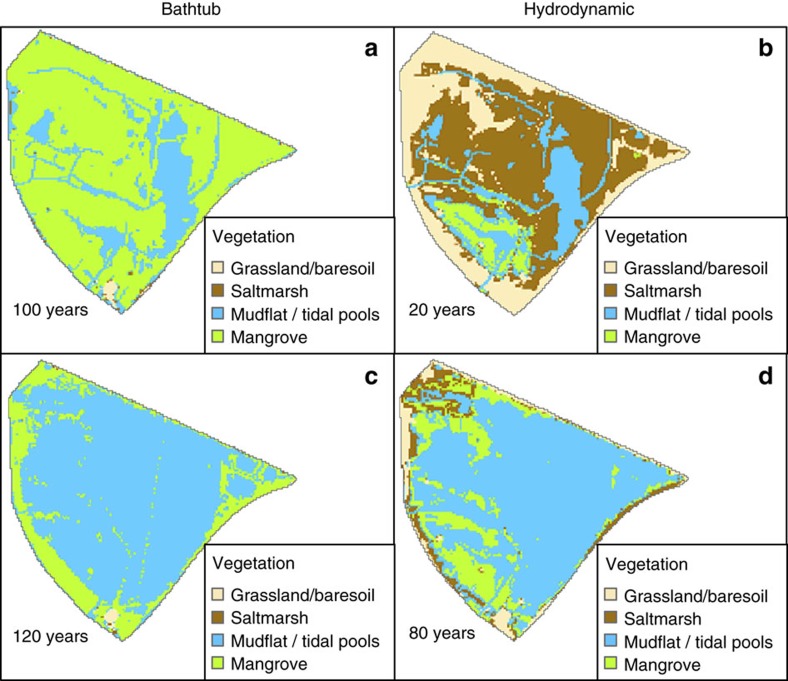
Wet land vegetation changes due to variable sea-level rise and variable soil surface elevation change with low suspended sediment.(a,b) 25–45% of vegetated area loss is predicted after 100 years in the bathtub model but considerably sooner (20 years) in the attenuated case. During this initial phase changes are slow due to low sea-level rise rates and also because losses are partially compensated by colonization of higher buffer zones. (c,d) After the initial period of slow change due to low rates of sea-level rise, wetland loss trajectory is similar to the results using constant rates of sea-level rise and a constant rate of surface elevation gain achieving 75–80% of vegetation loss at 120 years (bathtub model) and 80 years (hydrodynamic model). For complete results see Supplementary Figs 4 and 5.